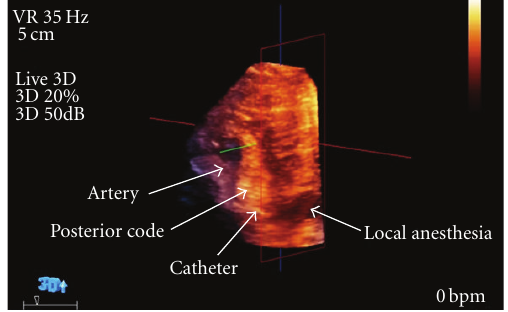
Figure 2: Oblique view of the nerve catheter inferior to the posterior